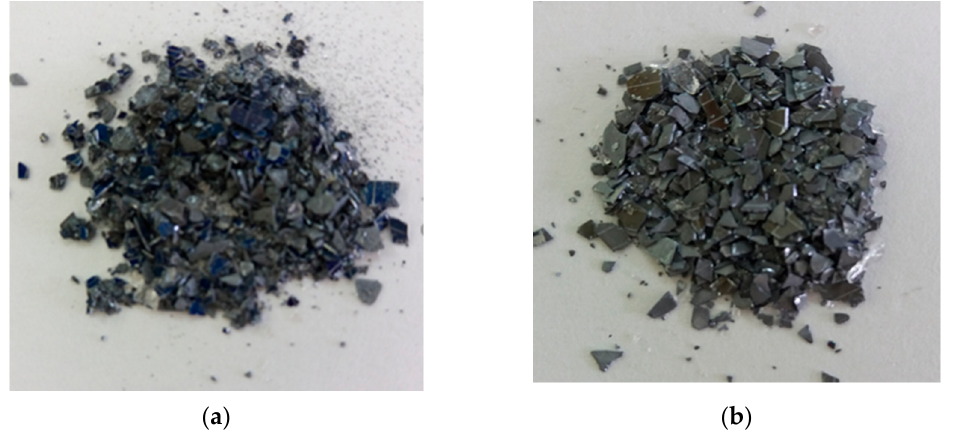
Figure 2. Photograph of recovered silicon after ( a ) 1.5 h etching time ( b ) 24 h etching time. The fractions of recovered silicon were weighted and their mass percentage consid- ering the initial amount in the sandwich before the chemical treatment was calculated. This mass percentage of the recovered solid as a function of the treatment time is shown in Figure 3. Each point represented in the graph indicates the yield calculation in three groups of samples treated in the corresponding time interval.